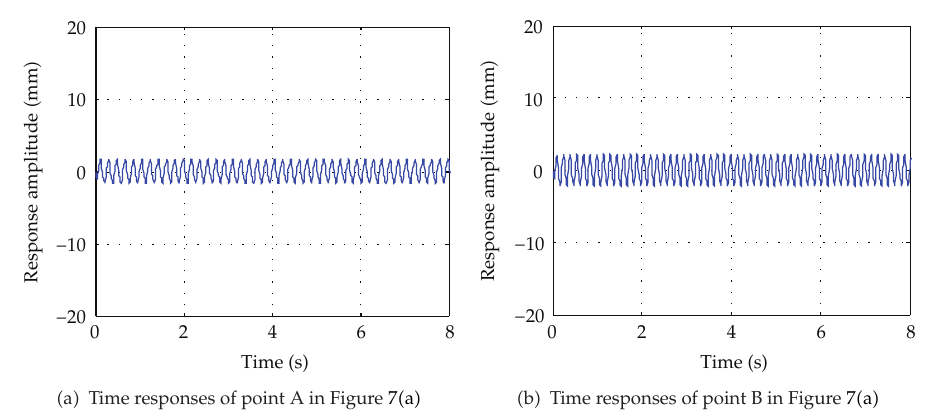
Figure 9: Time responses of the transverse displacement at electric field E (cid:8) 0 .